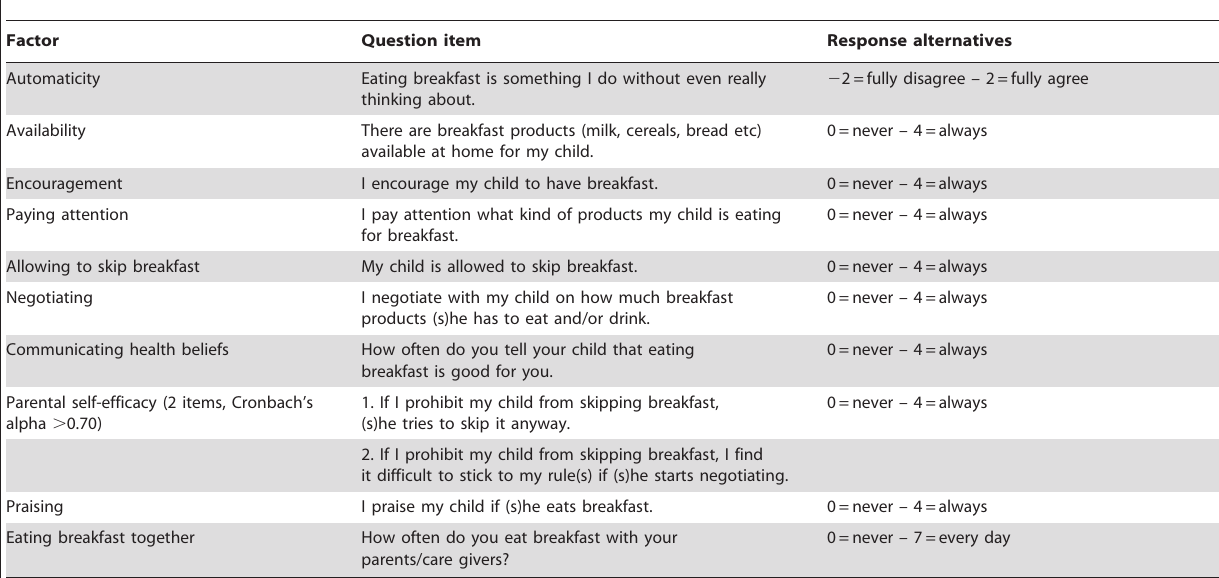
Table 1. Formulations of the questionnaire items and the psychometric characteristics.